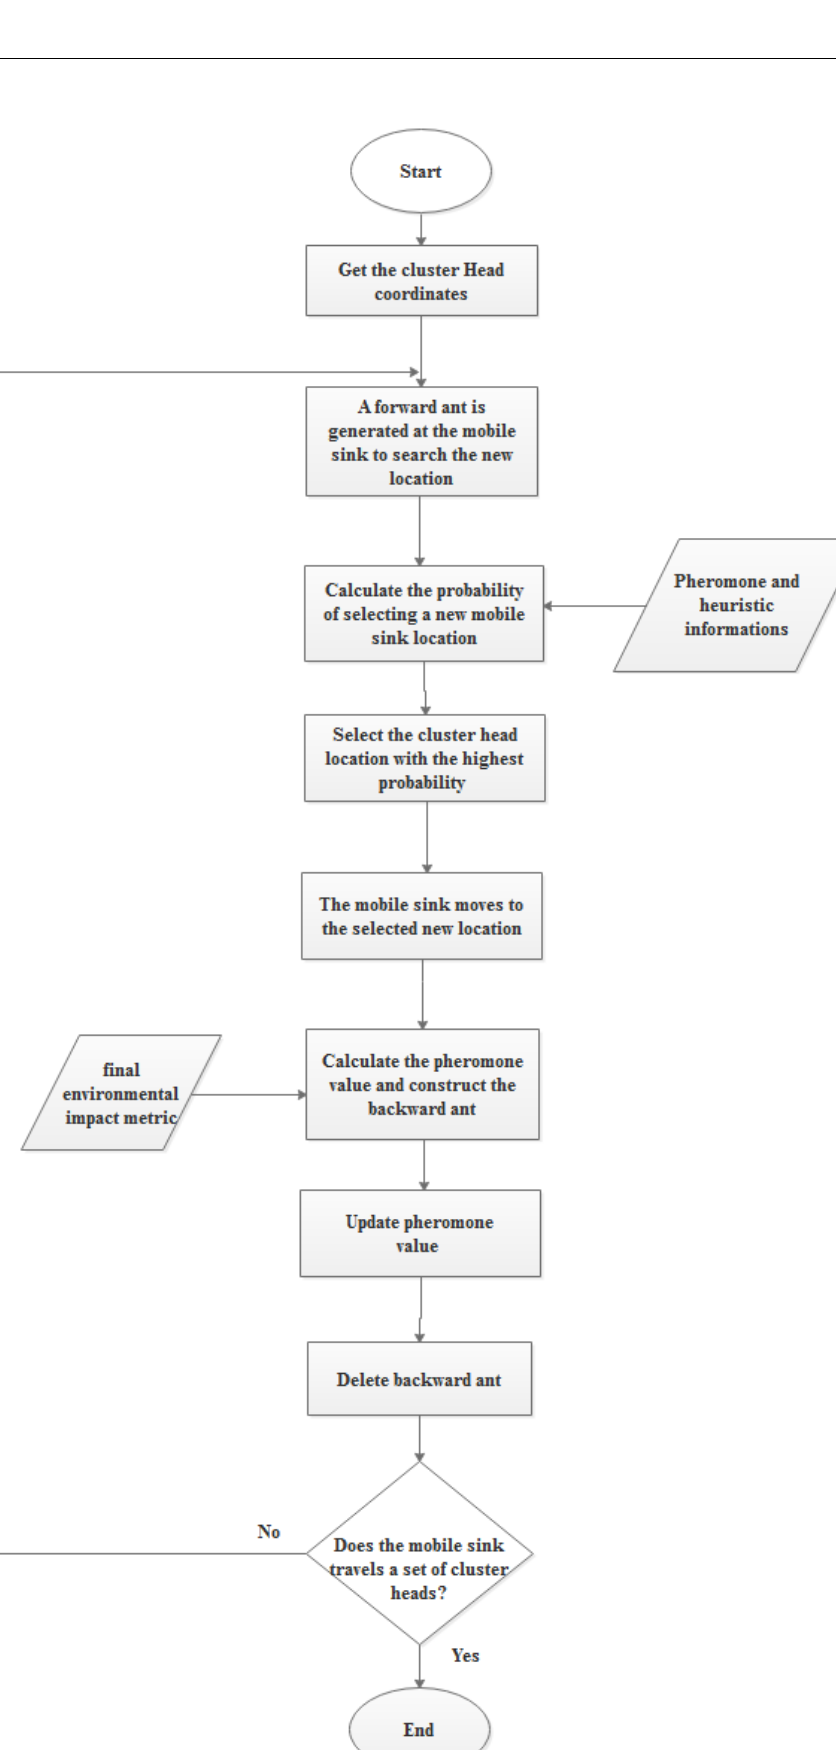
Figure 3. The proposed path planning algorithm flowchart.